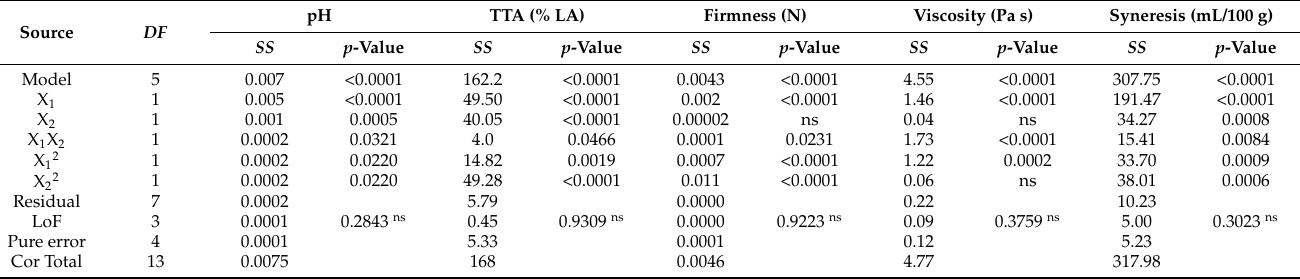
Table 5. ANOVA table for the independent and response variables 1